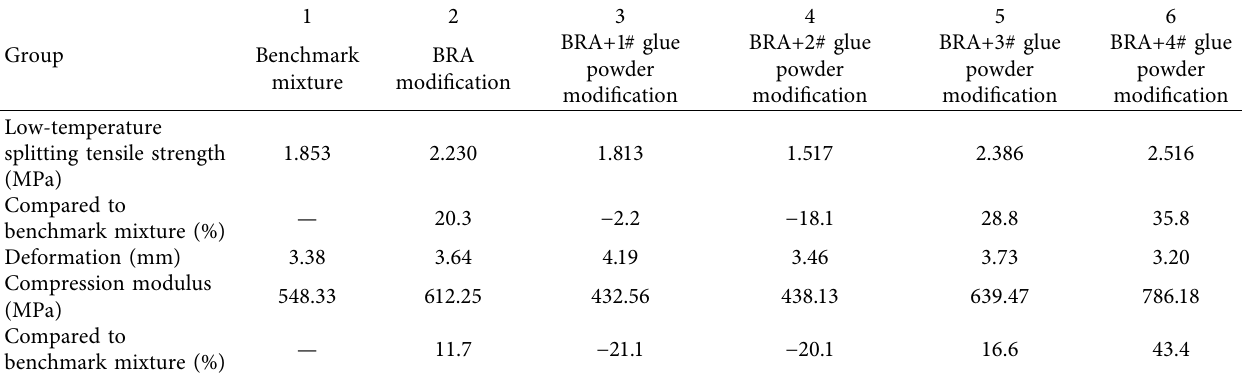
Table 9: Low-temperature splitting test results.